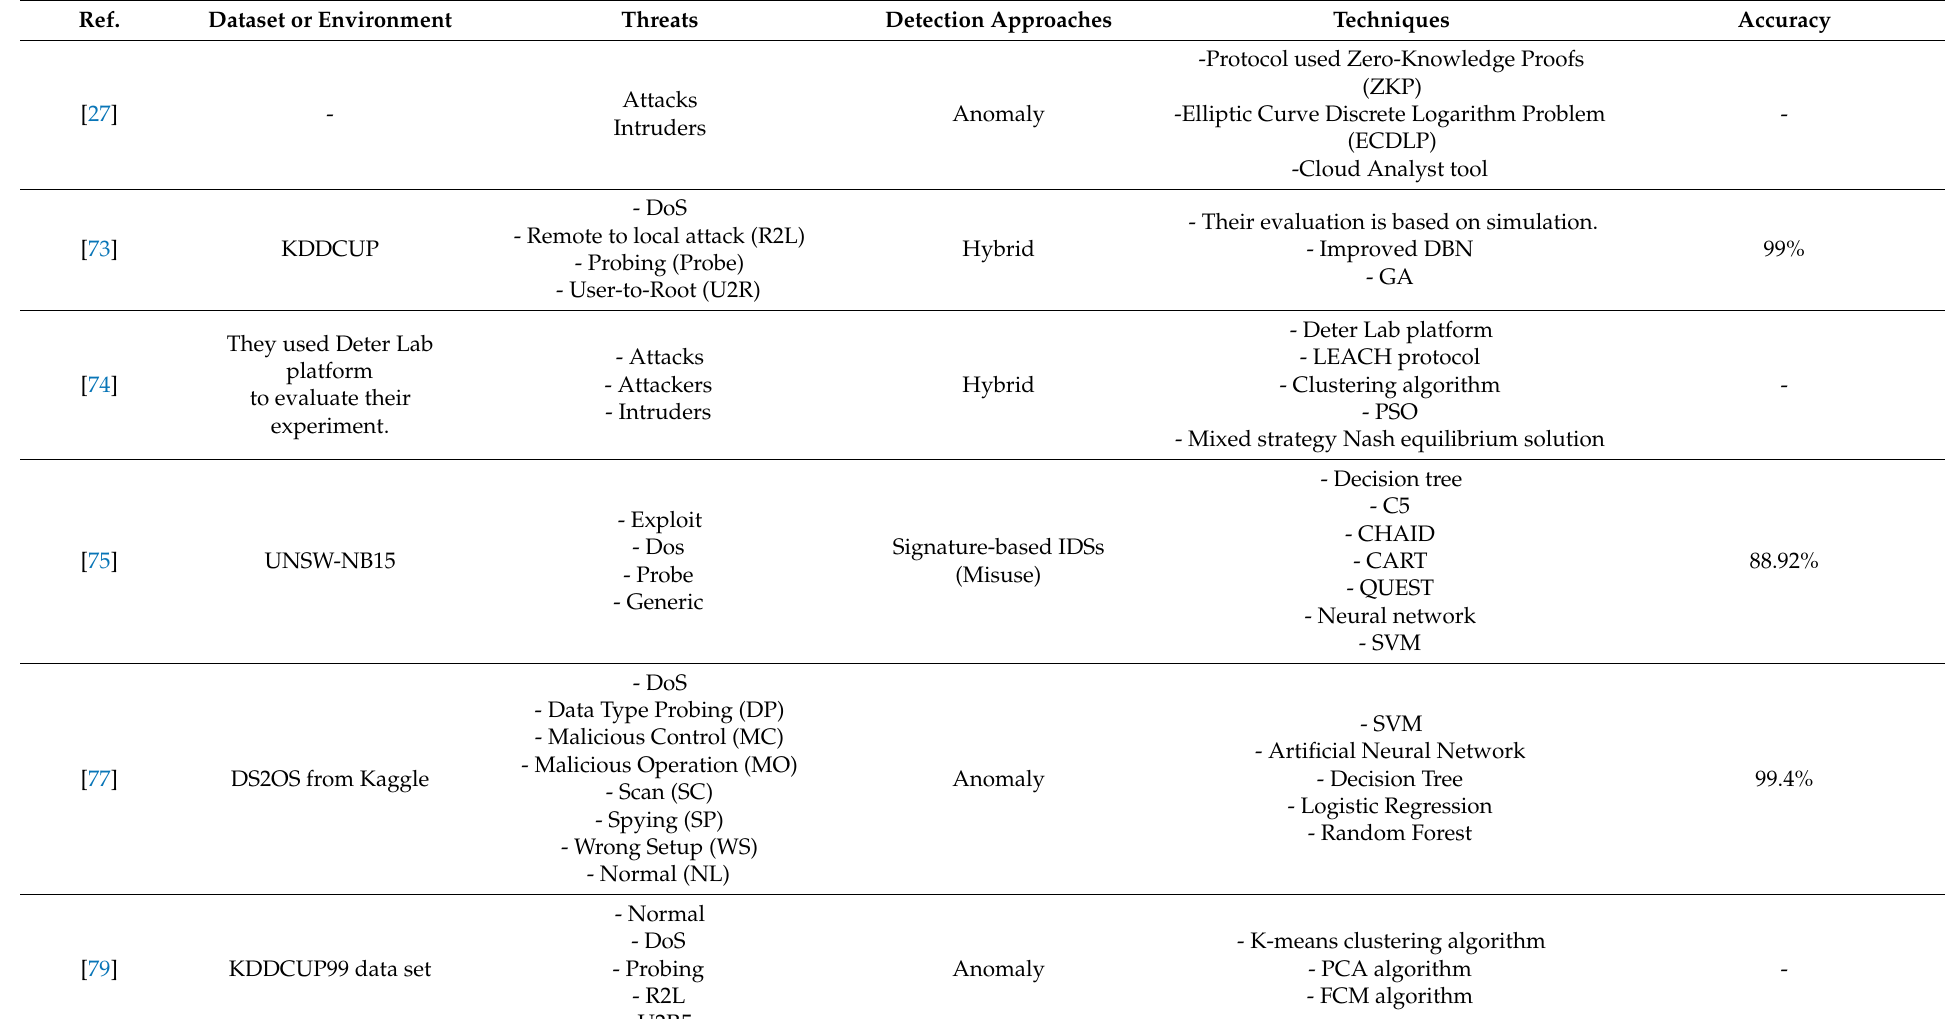
Table 5. ML-based IDS for IoT security.